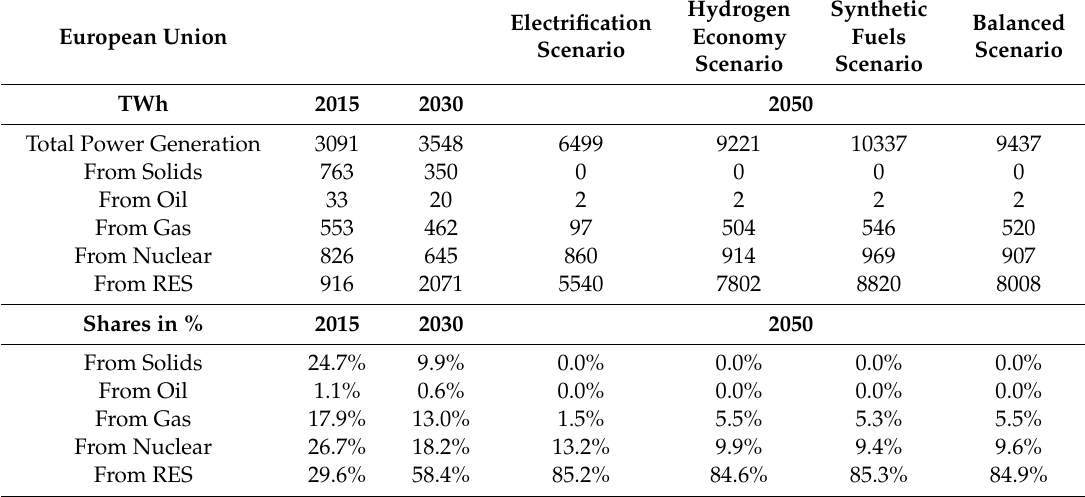
Table 8. Power Generation